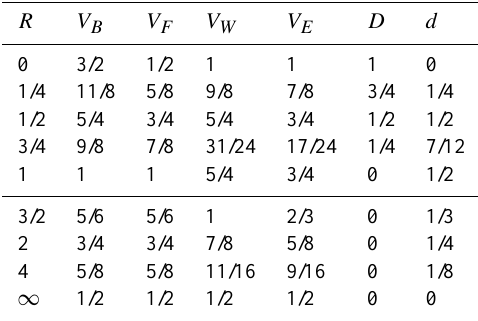
Table 1. Time averaged potentials for a rotating surface